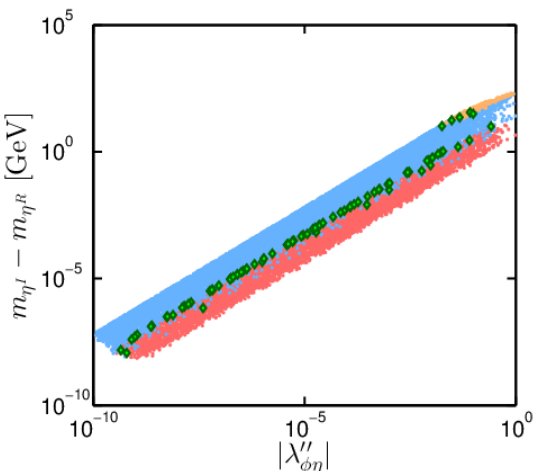
Figure 5 . Mass di(cid:11)erence m previous (cid:12)gure. Interesting is to notice that low values of m (cid:17) associated to high values of j (cid:21) 00